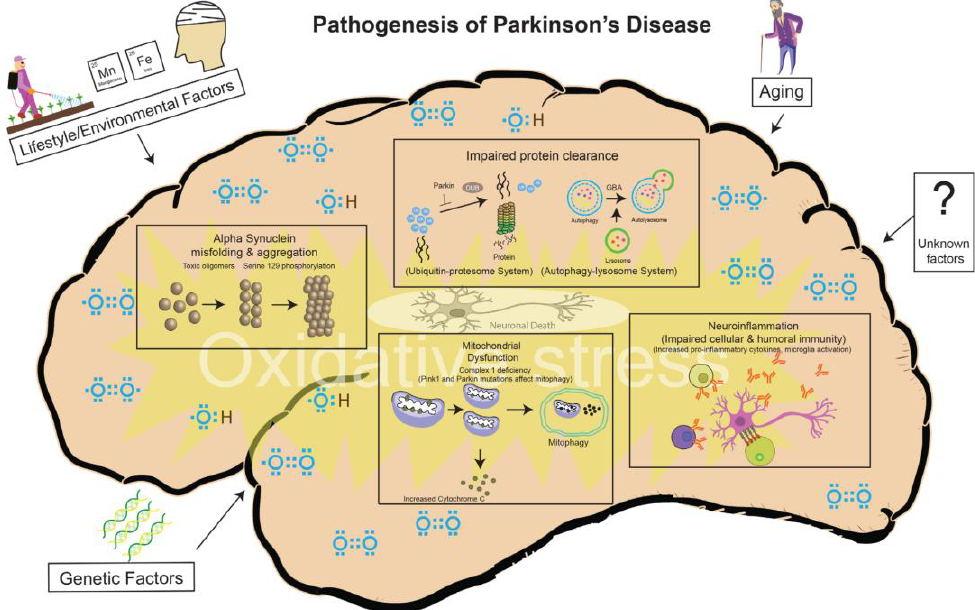
Figure 4. Pathogenesis of PD — a variety of cellular mechanisms, with a background of oxidative stress, coupled with aging, lifestyle/environmental, and genetic factors, contribute to PD-related neurodegeneration. Permission was taken from the original authors for using this diagram [120] and licensed under a BMJ Publishing Group Ltd. and Copyright Clearance Center 2020.